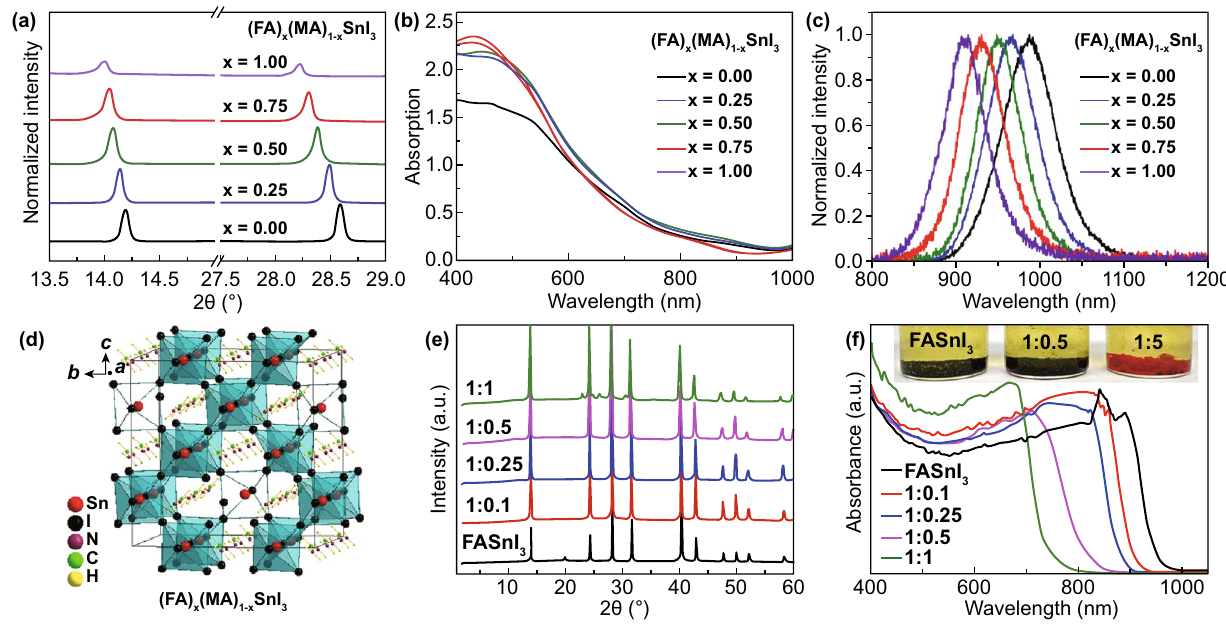
Fig. 6 a XRD patterns of one-step deposited (FA) x (MA) 1−x SnI 3 (x = 0.00, 0.25, 0.50, 0.75, and 1.00) films on ITO/poly(3,4- ethylenedioxythiophene)-poly(styrenesulfonate) (PEDOT:PSS) substrates. b Absorption spectra and c normalized PL spectra of the different perovskite films on quartz substrates. d A 2 × 2 × 2 supercell of (FA) 2 Sn 2 I 6 depicting a model of the hollow perovskite with two SnI 2 vacancies [(FA) 16 Sn 14 I 44 ]. e XRD patterns and f optical absorption of the {en}FASnI 3 perovskite crystals with various molar ratios of FA to {en}. Repro- duced with permission from Ref.